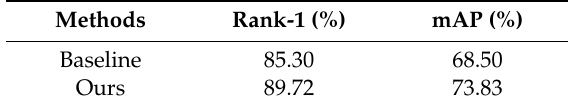
Table 1. The performance comparison between baseline and the proposed method.